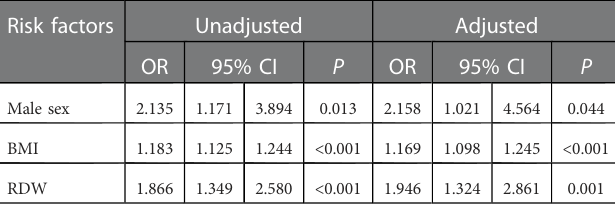
TABLE 5 Multivariate logistic regression analysis of LVH in pediatric essential